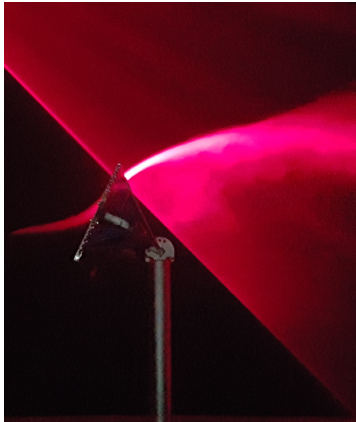
Figure 4. The scaled model of the PV panel under investigation with the flow visualisation though the smoke and laser